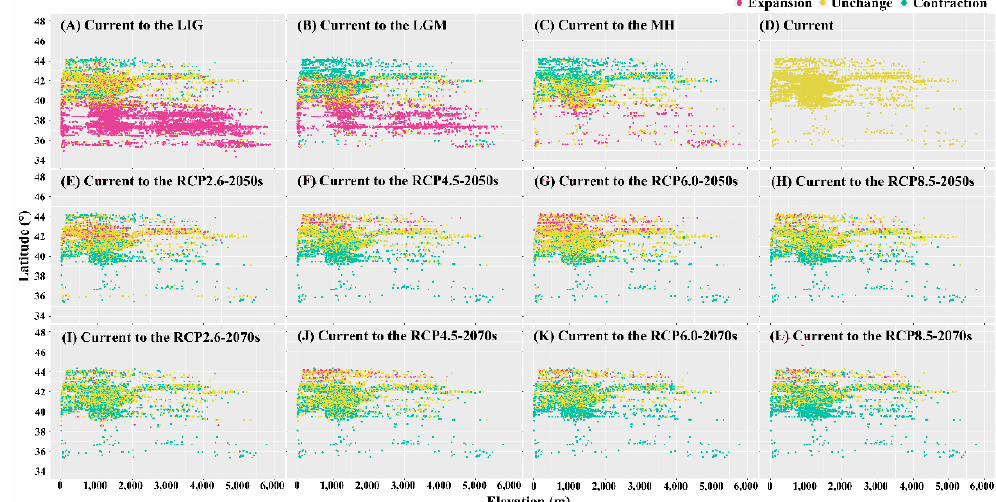
Figure 8. Altitude and latitude change of the suitable habitats of Lonicera oblata under different scenarios compared with the current condition. Each dot represents a grid cell in the suitable area data. Purple dots represent expansion, green dots represent contraction, yellow dots represent unchanged. ( A ) Current to the LIG; ( B ) Current to the LGM; ( C ) Current to the MH; ( D ) Current; ( E ) Current to RCP6.0-2050s; ( F ) Current to RCP4.5-2050s; ( G ) Current to RCP6.0-2050s; ( H ) Current to RCP8.5-2050s; ( I ) Current to RCP2.6-2070s; ( J ) Current to RCP4.5-2070s; ( K ) Current to RCP6.0-2070s; ( L ) Current to